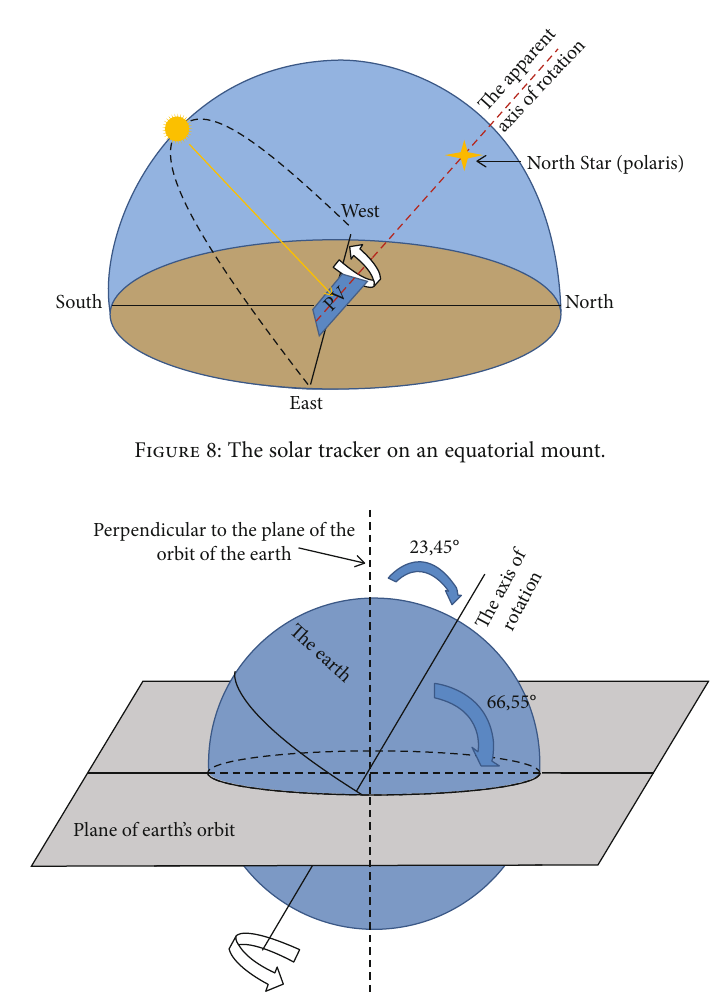
Figure 9: The inclination of the axis of rotation with respect to the plane of the earth ’ s orbit. Spring equinox 20 or 21 march the sun is perpendicular to the equator